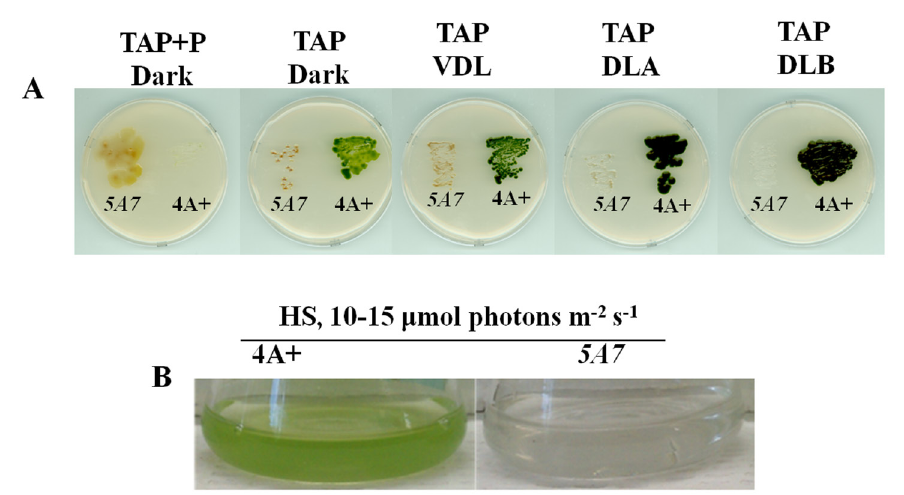
Figure 2. Growth phenotype of 5A7 . ( A ) This figure shows the phenotypic difference of 5A7 compared to the parental strain, 4A+ on heterotrophic/mixotrophic agar media (TAP) plates under five different light conditions: dark + paromomycin (P), dark, very dim light (VDL,